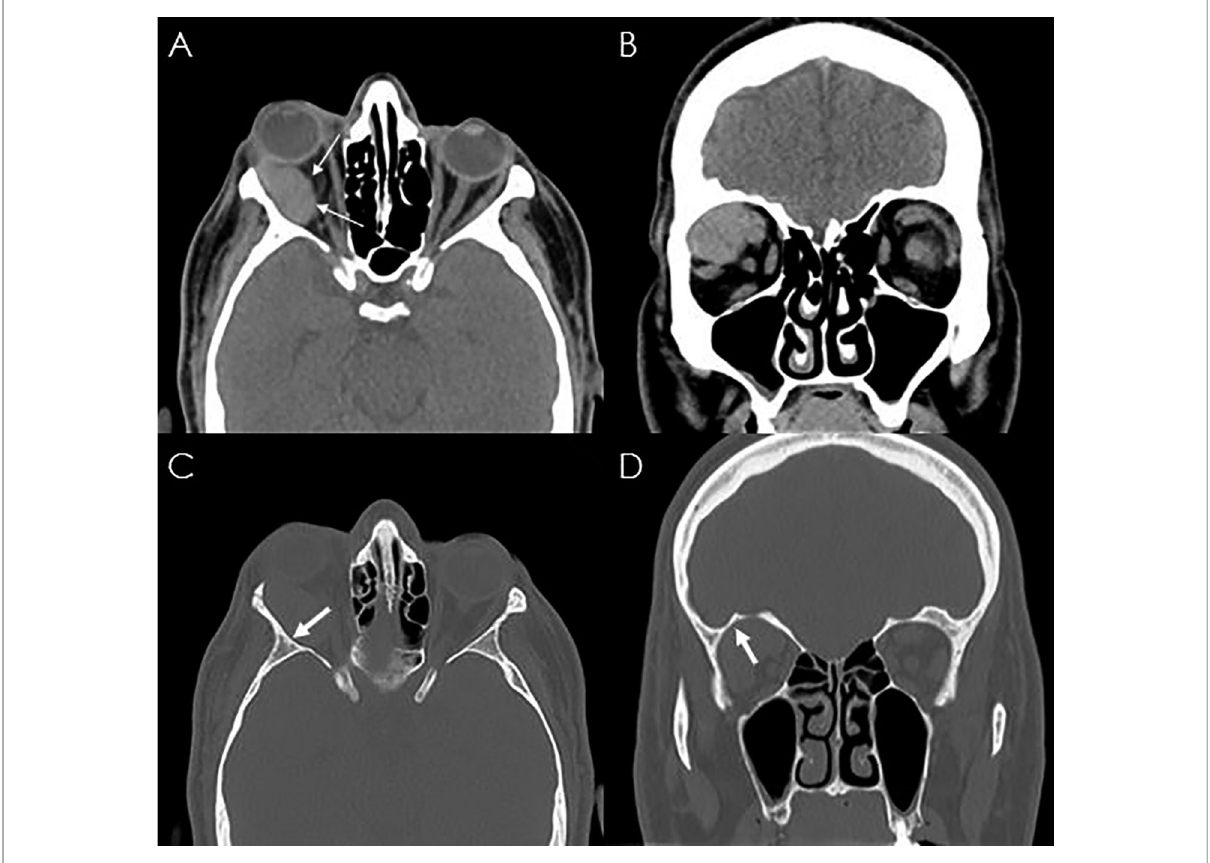
FIGURE 1 CT scan of the skull showing a right isodense well-encapsulated orbital lesion ( A ), displacing the extraocular muscles ( B ). The arrow indicates the mild bone scalloping of the orbital roof ( C,D